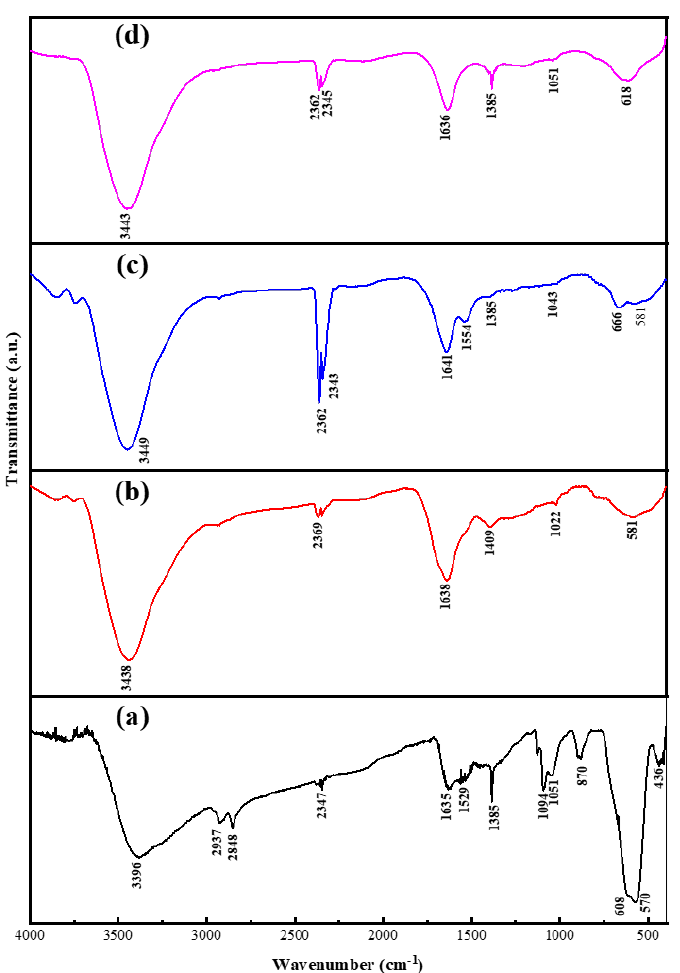
Figure 1. FTIR spectra for ( a ) Fe 3 O 4 NPs; ( b ) Fe 3 O 4 @C-T 190 t 3 ; ( c ) Fe 3 O 4 @C-T 190 t 4 ; ( d ) Fe 3 O 4 @C-T 190 t 5.